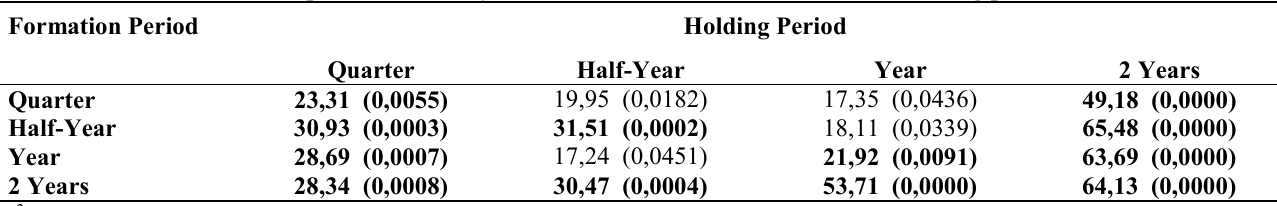
Table 5: Results of the bond quartile summary tables for the different formation and holding periods Formation Period Holding Period